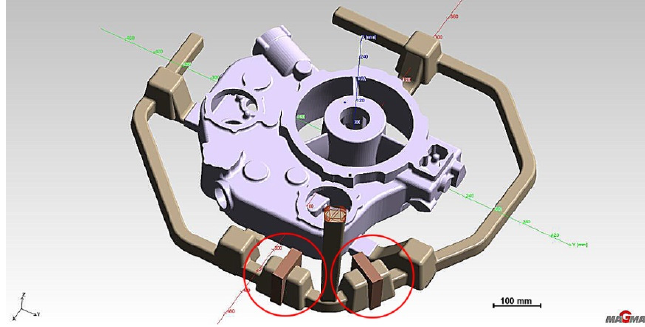
Figure 10. Stage 2 Porosity in the feeding gate areas.